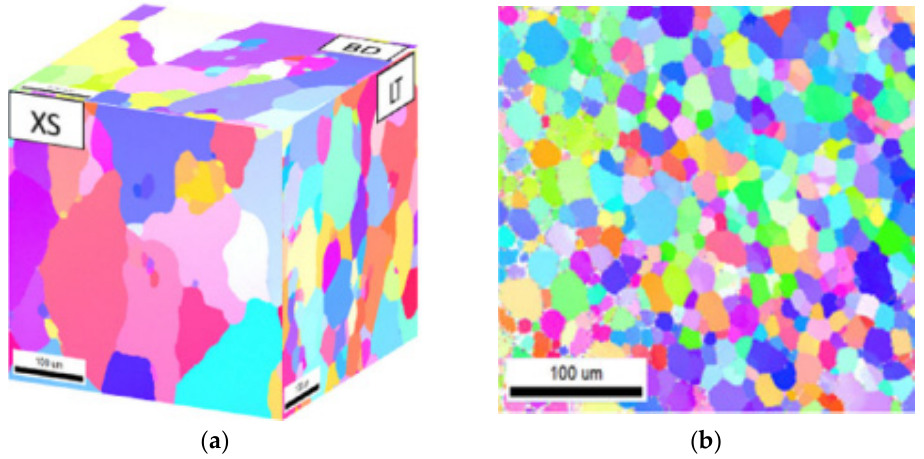
Figure 11. The comparative grain orientation for the feedstock and as-deposited AA6061 [42]. ( a ) 3-D EBSD map of initial feedstock. ( b ) EBSD map of deposition cross section.